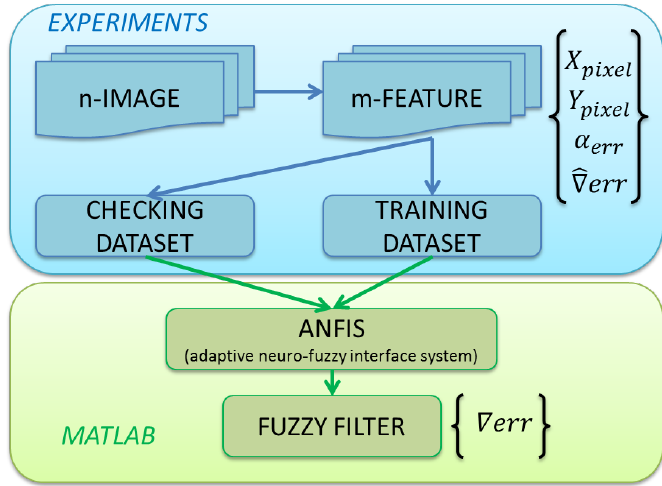
Figure 11. Diagram corresponding to the experimental set-up followed in the experiments